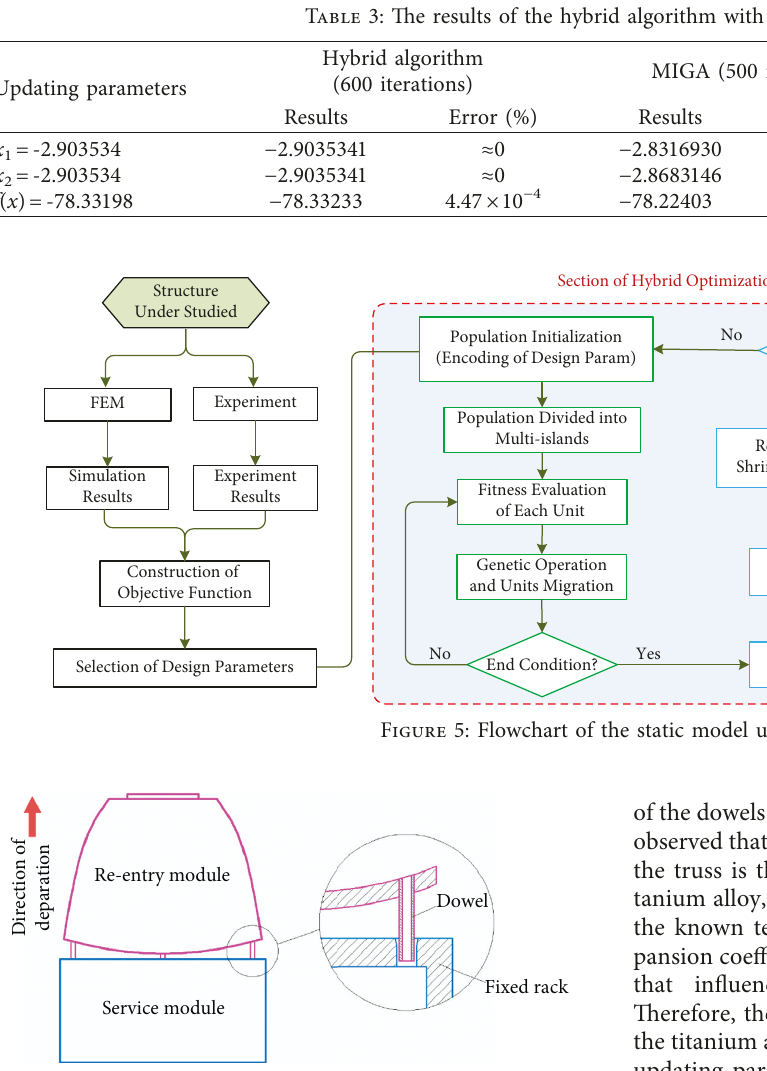
Figure 6: The connection of the re-entry module and service module.